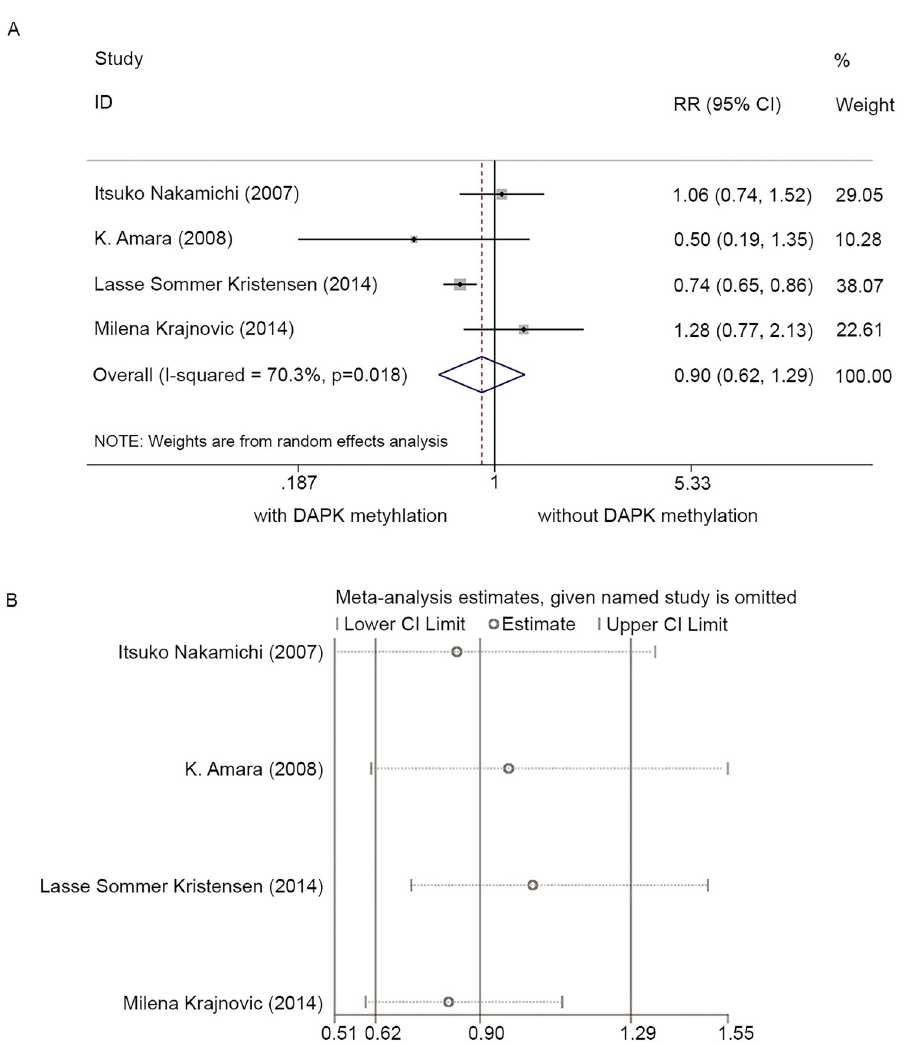
Fig 4. Association of DAPK methylation with 5-year survival rate in DLBCL patients. (A) Forest plot (B) Sensitivity